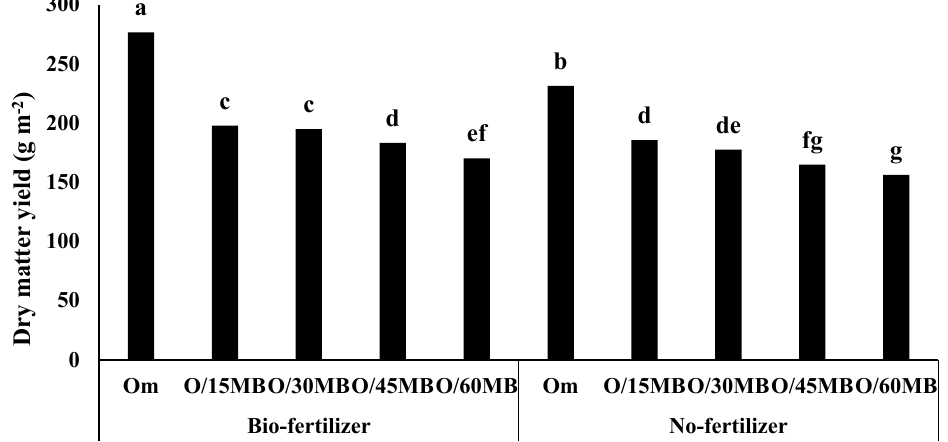
Figure 3. The dry matter yield of marjoram under the interaction of cropping patterns and fertilizer application. Om: marjoram monocropping; O/15MB: intercropping ratios of 100% marjoram + 15% mung bean; O/30MB: 100% marjoram + 30% mung bean; O/45MB: 100% marjoram + 45% mung bean; O/60MB: 100% marjoram + 60% mung bean. Different lower-case letters above the bars indicate significant ( p ≤ 0.05) differences.